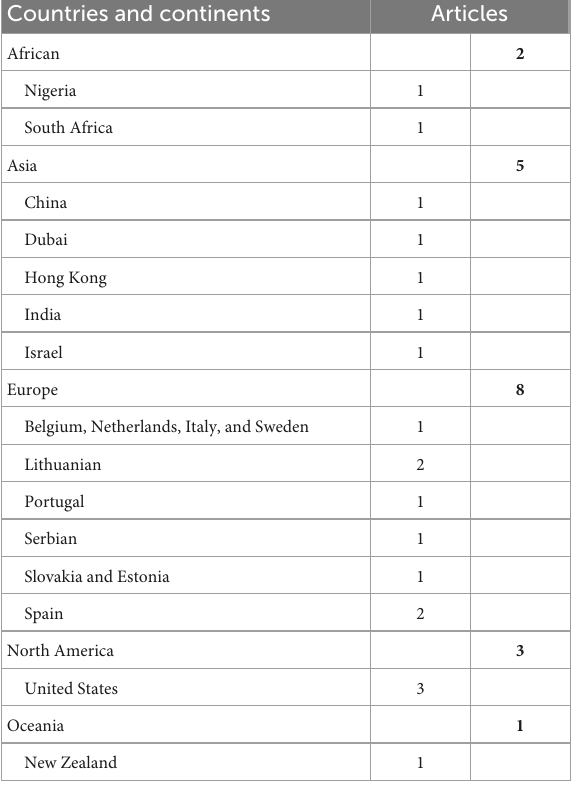
TABLE 2 Summary of countries and continents. Countries and continents Articles